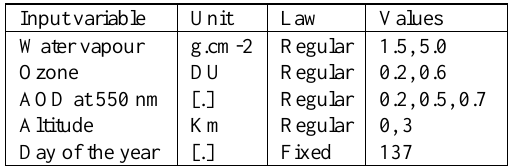
Table 2. Input specifications for MODTRAN 5 Top-of-atmosphere sensor radiance values are derived by convolution of the spectral radiances with the sensor spectral response functions of PROBA-V and SPOT-VEGETATION (Figure 2). From this, top-of-atmosphere reflectance values can